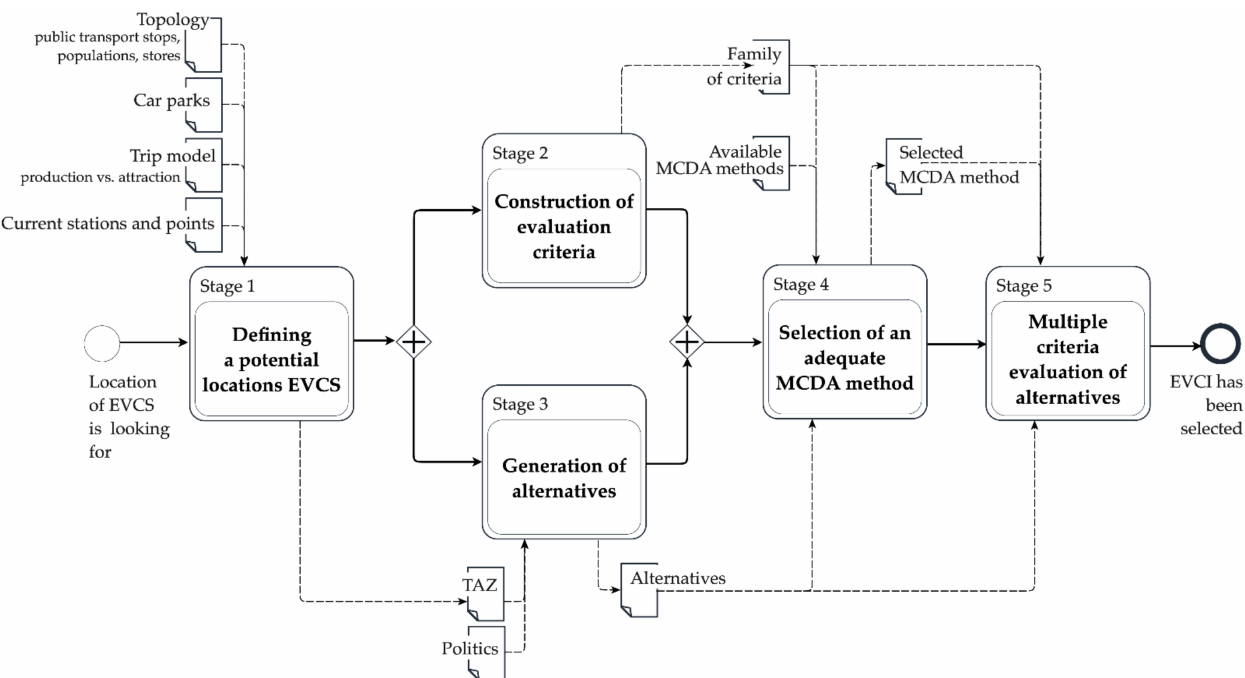
Figure 1. The concept of the proposed methodology of EVCI design.